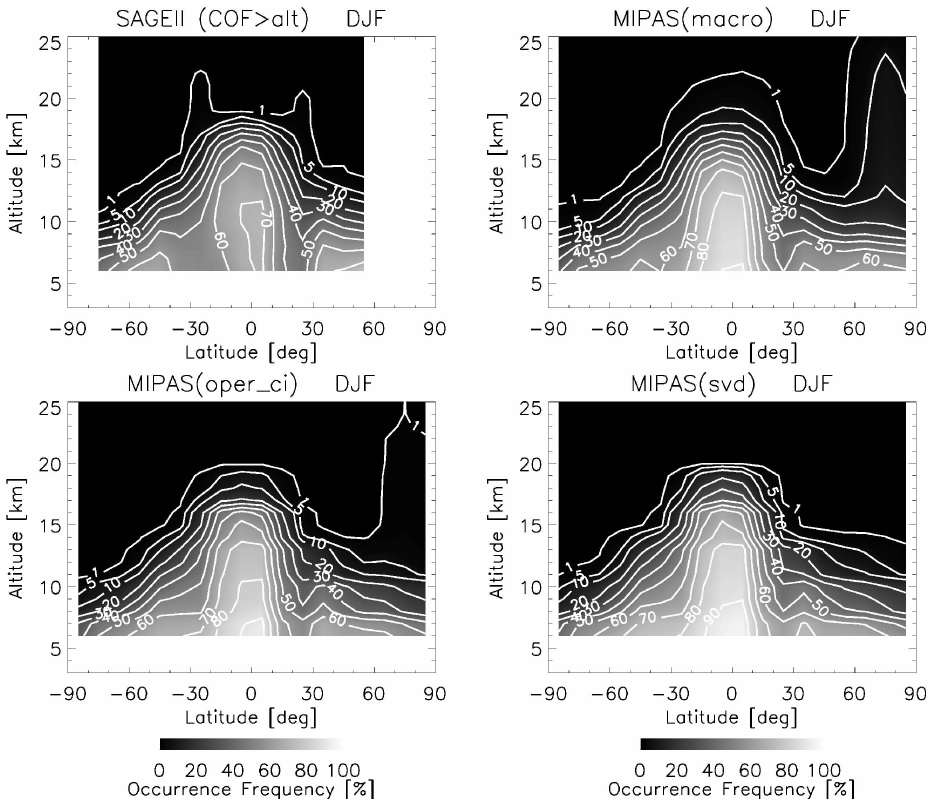
Fig. 15. Zonal mean cloud occurrence frequencies (COF) above a certain altitude for the MIPAS detection methods MACRO, OPER CI and SVD in comparison to SAGE II (top left) for the Dec-Jan-Feb (DJF) season 2002/2003 and the climatology time period of December 1998–November 2004,